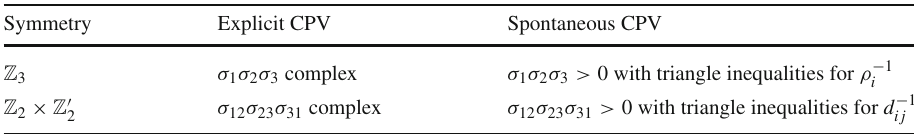
Symmetry Explicit